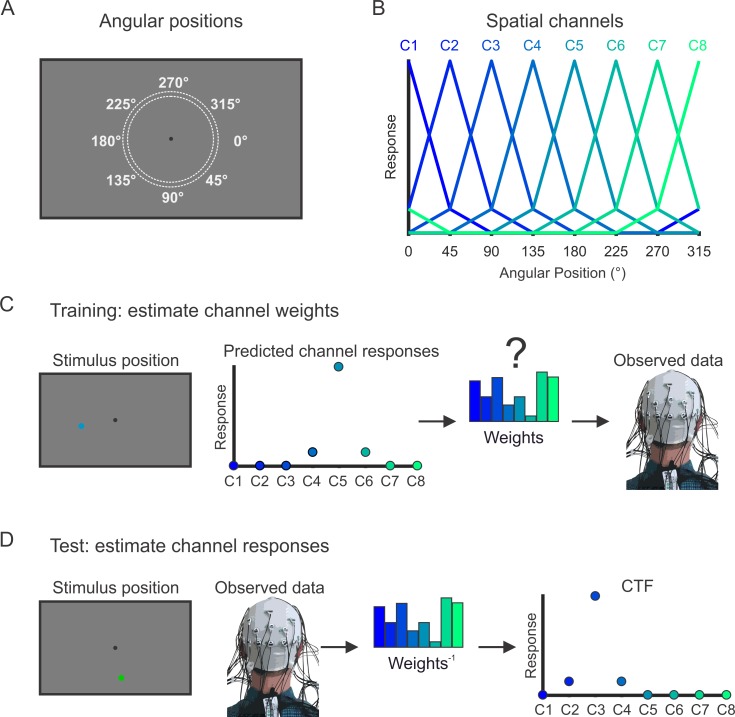
IEM procedure for reconstruction spatial CTFs.(A) The stimuli varied in angular position around the fixation point. Stimuli were categorized as belonging to 1 of 8 positions bins (a 45° wedge of positions), centered at 0°, 45°, and so forth. (B) We modeled power at each electrode as a linear combination of the 8 hypothetical spatial channels (C1–C8). The curves show the predicted response of the spatial channels across angular positions. (C) In the training phase of the analysis, we estimated the relative contributions of each of the 8 channels to power measured at each electrode (called “channel weights”). (D) In the test phase of the analysis, we used the channel weights obtained during training to estimate the channel responses from the multivariate pattern of power across electrodes. Critically, the data used in the training and test phases of the analysis were independent to avoid circularity. For details, see Materials and methods. Data are available at https://osf.io/47cmn/. CTF, channel-tuning function; IEM, inverted encoding model.